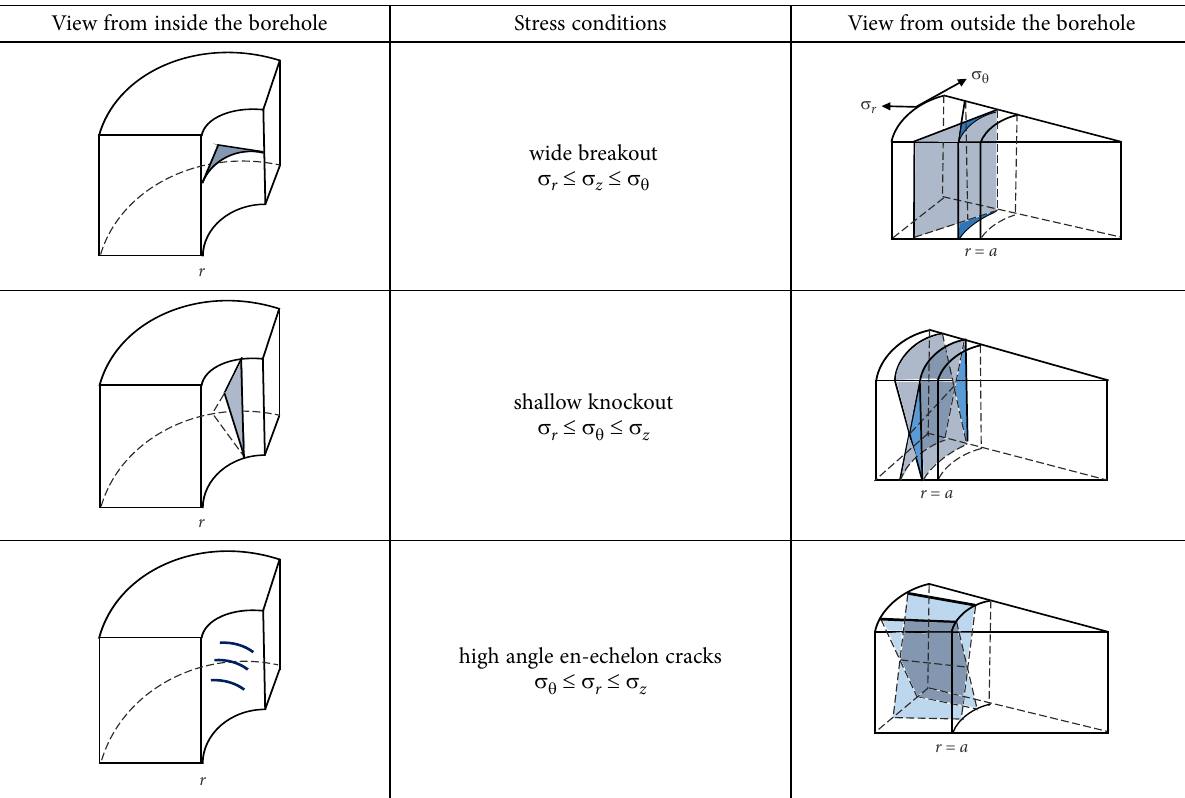
View from outside the boreholeStress conditionsView from inside the